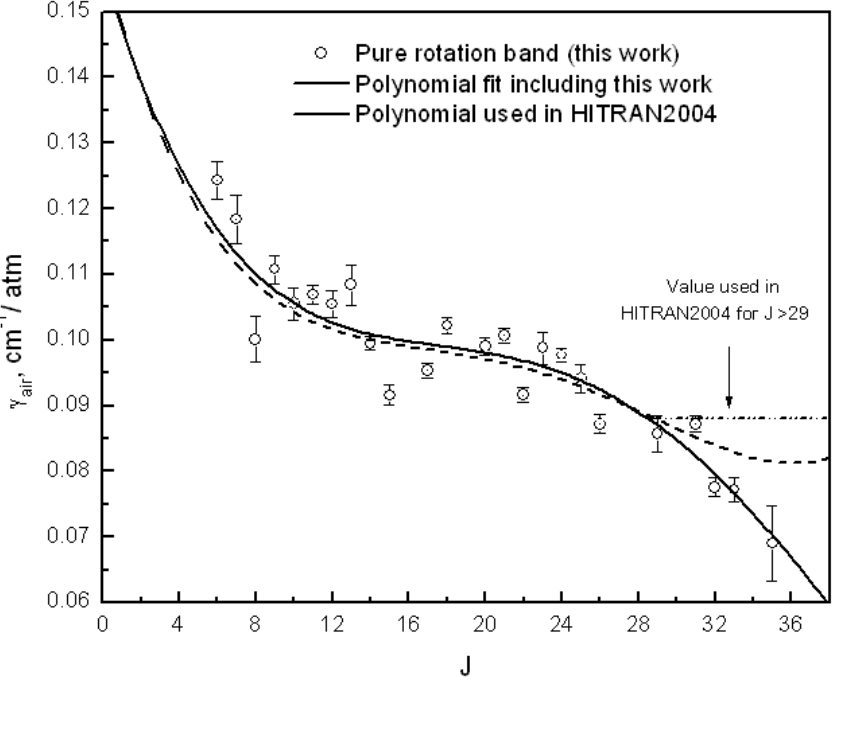
Figure 9. Air broadening coefficient of HCN measured over the frequency range 530 GHz to 3.3 THz. Measured values (open points), HITRAN 2004 polynomial (dotted line), updated polynomial for HITRAN 2008 (solid